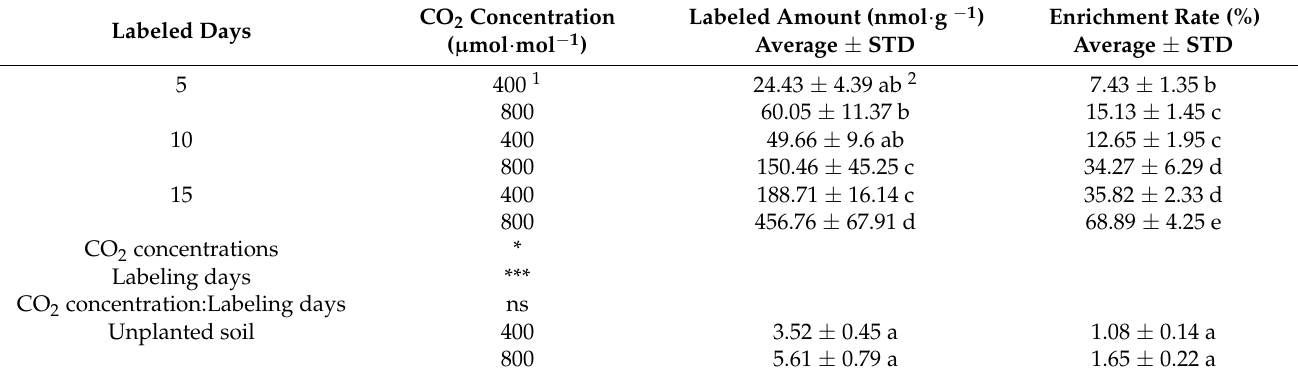
Table 1. The total enrichment of 13 C into the PLFA of individual soil samples under varied CO 2 concentration treatments. Labeled Days